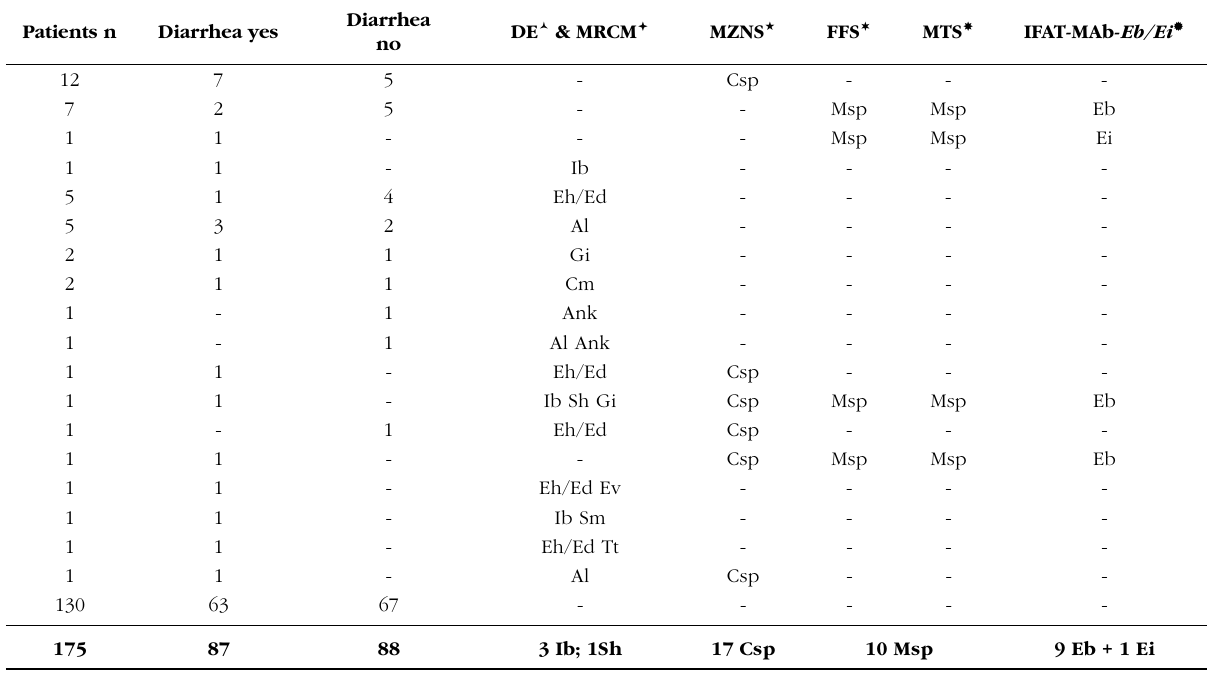
Table I. - Diagnosis of intestinal parasites in optic microscopy in 175 hospitalized AIDS patients in four hospitals in Kinshasa